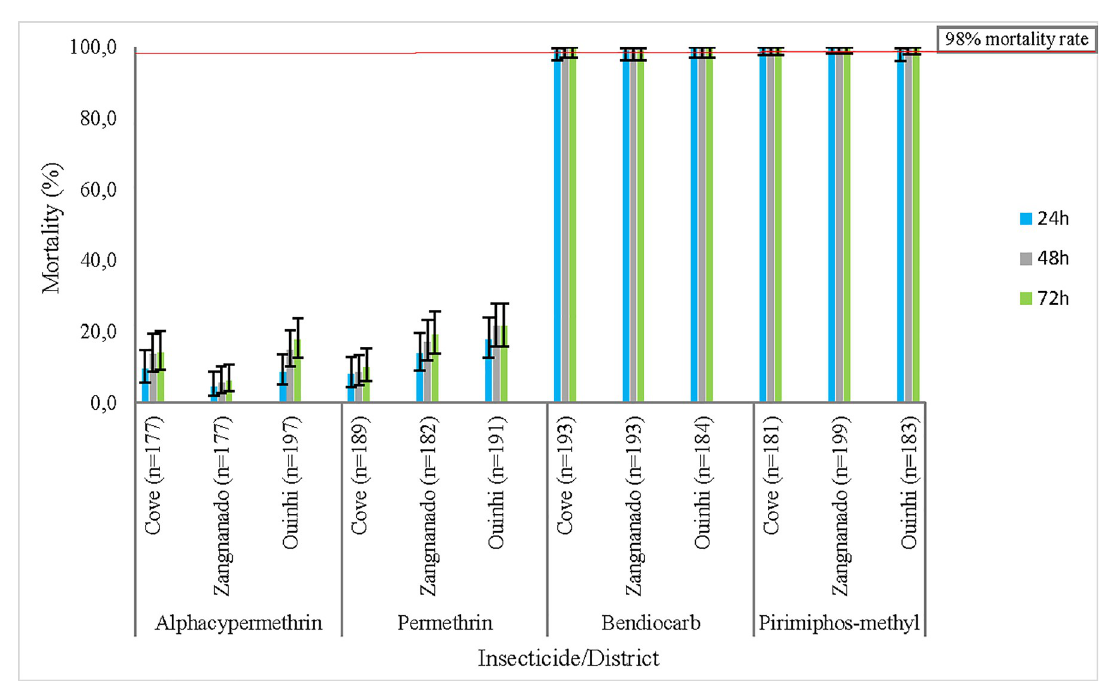
Fig 4. Mortality rates of An . gambiae s.l. to 0.05% alpha-cypermethrin, 0.75% permethrin, 0.1% Bendiocarb and, 0.25% Pirimiphos-methyl, the error bars indicate the confidence intervals.